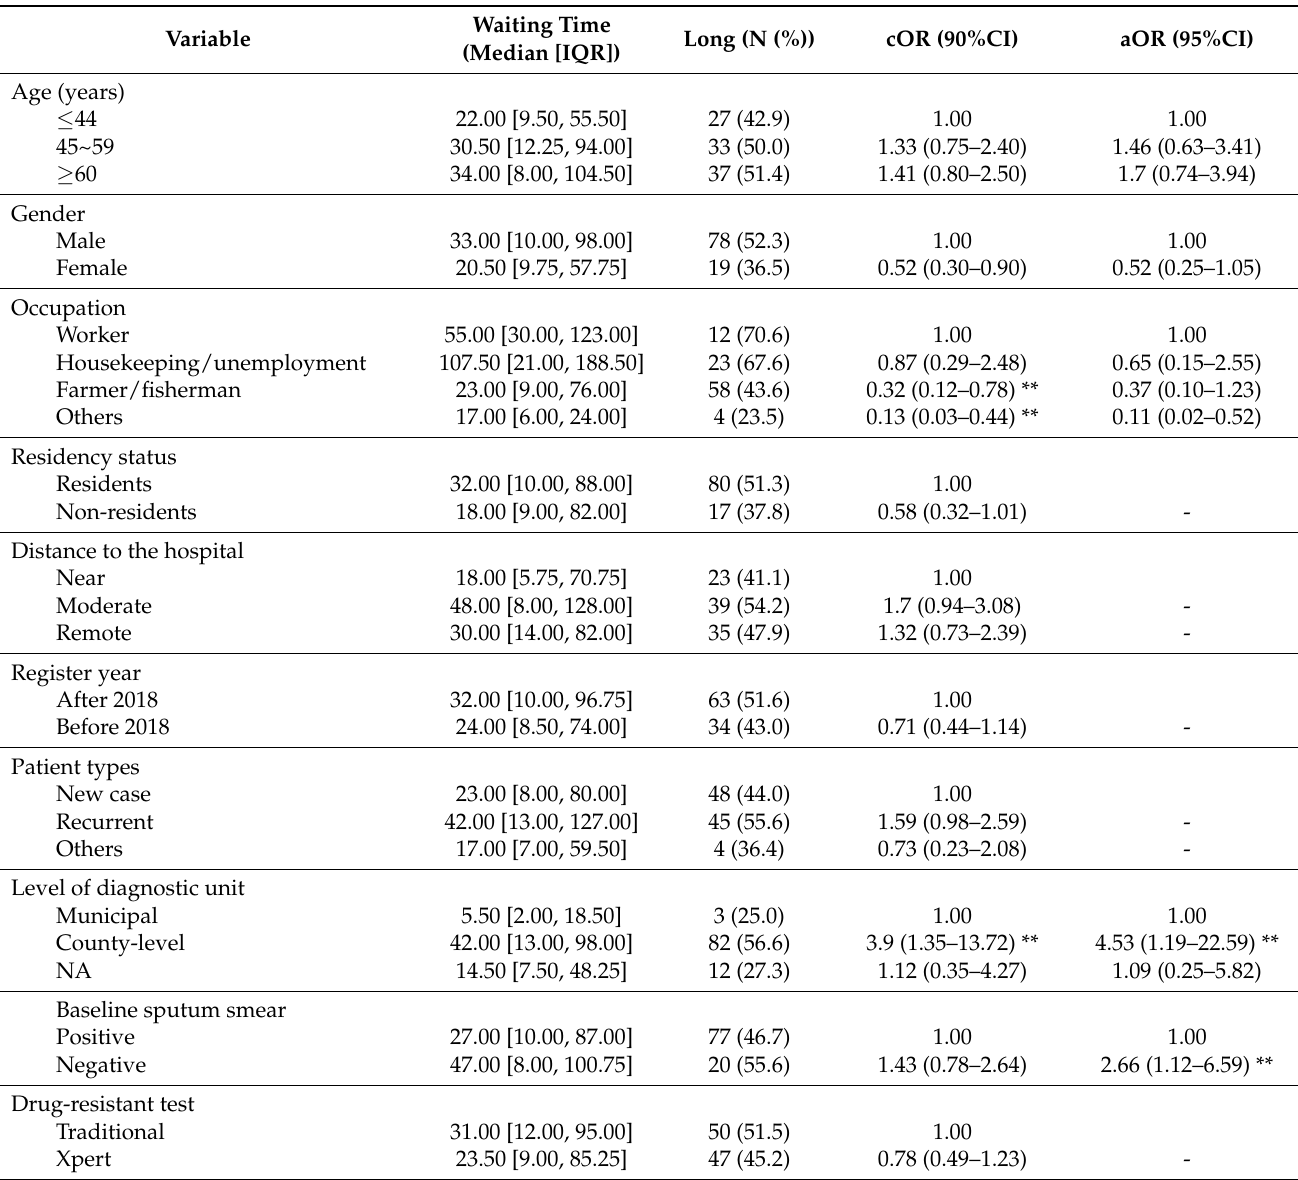
Table 4. Association of clinical and socio-demographic factors with waiting time for treatment among MDR/RR-TB patients (N =